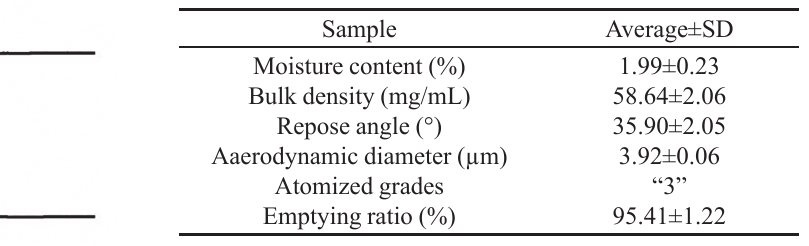
TABLE III - Micromeritic of TDF-PLGA-MS